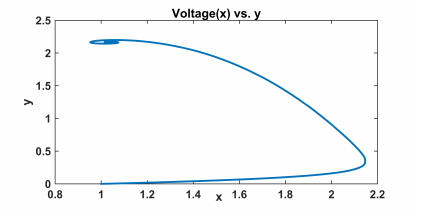
Figure 20. Recovery variable (right) with a constant external current value, I(t) = 4.5 µ